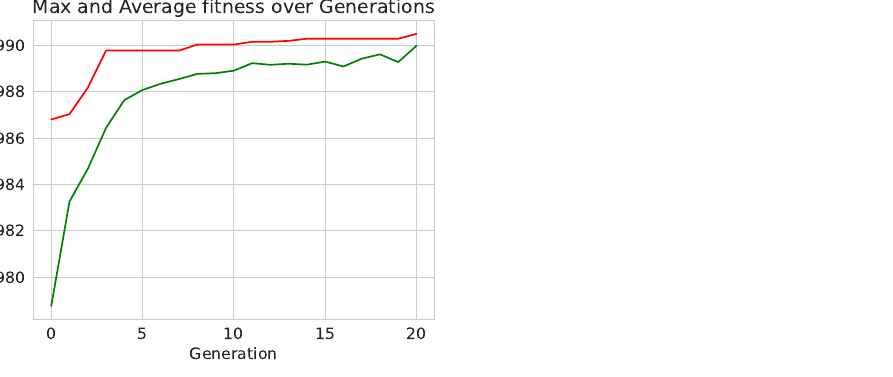
Figure 4. Min/Average fitness function value over generations of the hyperparameters direct genetic search